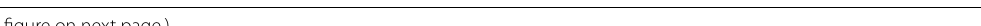
figure on next Fig. 2 Relative expression analysis of 12 DEGs during the early stage of B. cinerea infection via RT-qPCR. a Hierarchical cluster analysis of the indicated samples based on gene transcript levels. Each gene is represented by a single row of coloured boxes, and each small rectangle with different colours represents the log2 value of the relative gene expression level. b Comparison of gene expression levels with or without tomato leaf induction. The Y-axis represents the log2 value of the relative expression level. The expression level of each gene at conidial stage was set as ‘1’ and used as sample control. BcTubulin was used as an endogenous control. The values represent the average values, and the error bars indicate the standard deviations of 3 technical replicates in one experiment. All experiments were repeated three times with consistent